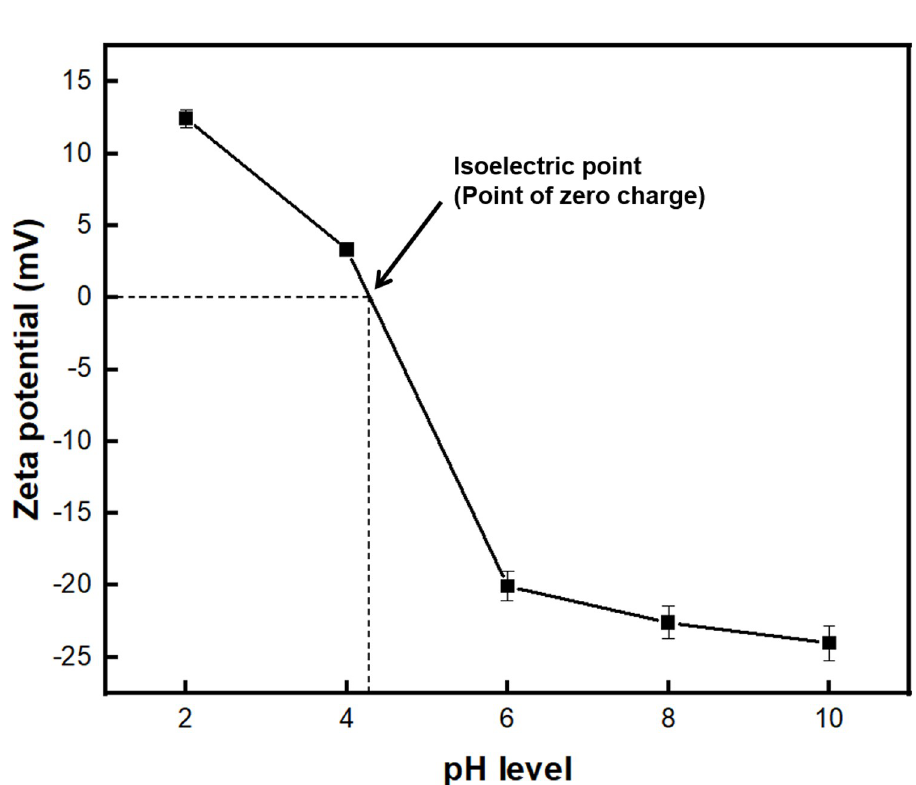
Fig 11. Zeta potential (mV) of BC-COF bio-leather with varied pH level (Extraction conditions: Liquor ratio of 1:10 (w/v), coffee at an amount of 200 wt% BC, 90˚C, 1 h; dyeing conditions: Fabric-to-liquor ratio of 1:10 (w/v), 70˚C, 30 min, meta-mordanting with 1% of FeSO 4 ; dye adsorption conditions: 50 mg/L of methylene blue solution with a fabric-to-liquor ratio of 1:200 (w/v), 25˚C, 30 min).